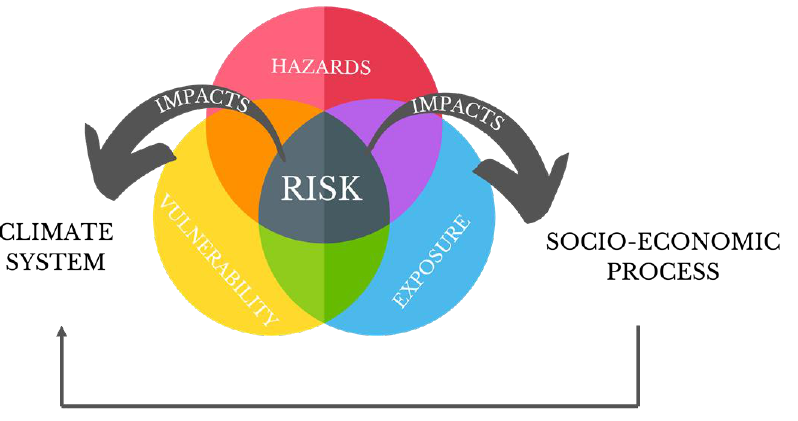
Figure 1. Scheme of the interaction among the physical climate system, exposure, and vulnerability producing risk. Based on [1].